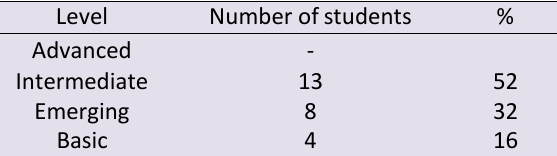
Figure 2 : Example of Students’ Response of a question on Purposes of Making a Product which earns a score of 1. In English, it equals as “Making a tool to solve the problem in order to find a solution”